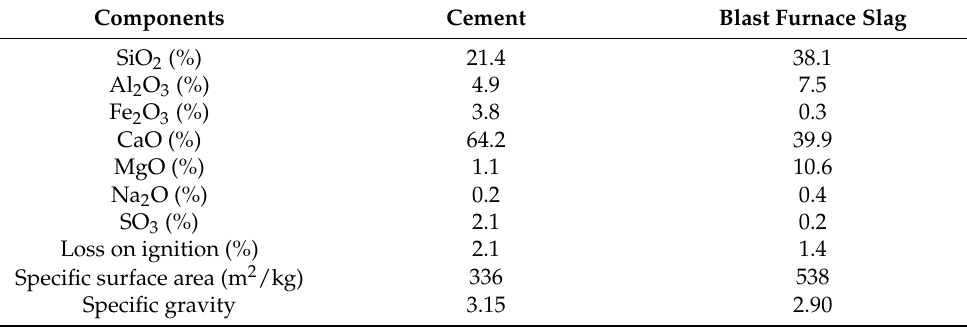
Table 1. Composition and physical properties of cement and blast furnace